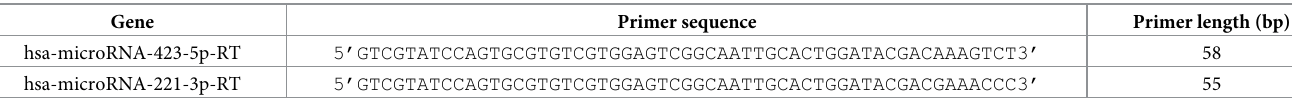
Table 1. Specific reverse transcription primers of microRNA-423-5p and microRNA-221-3p. Gene Primer